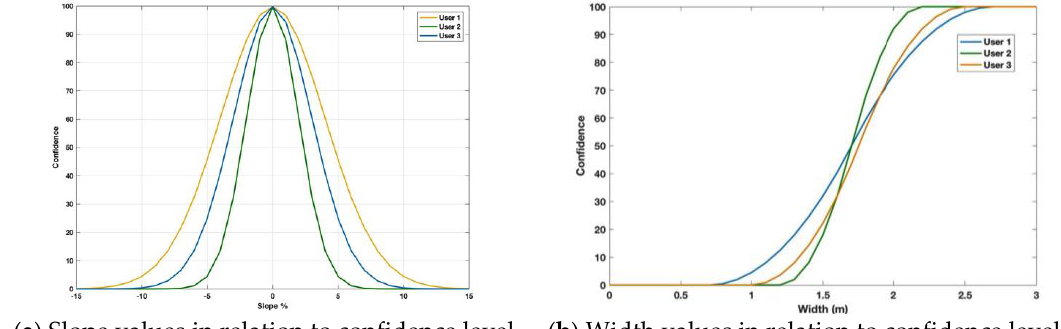
Figure 2. A simulation of the relationship between the slope and width values of a segment with regard to confidence levels of users.